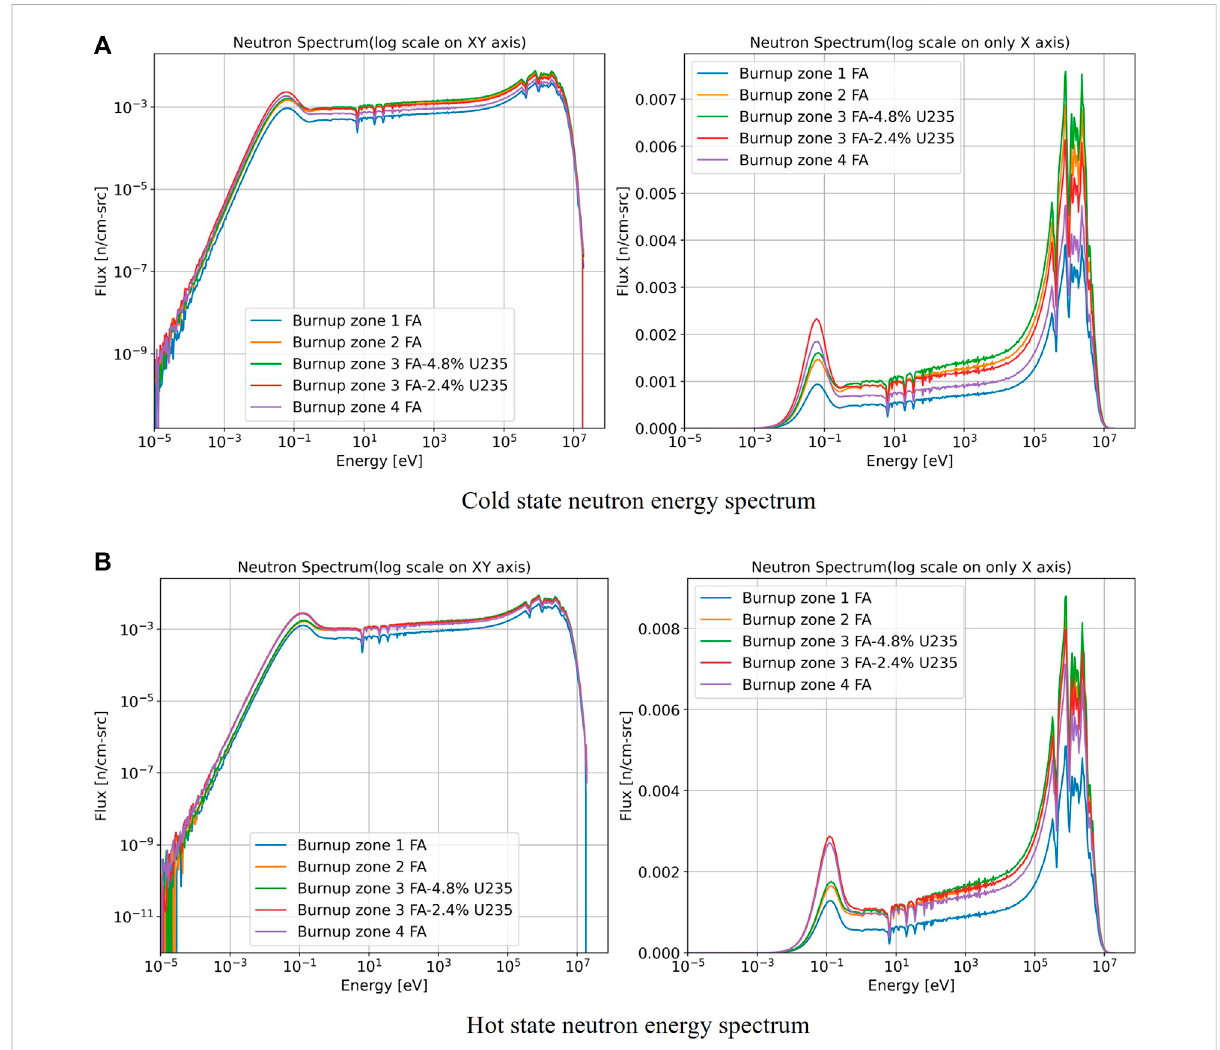
FIGURE 9 The neutron energy spectrums of different position fuel assemblies in the (A) cold and (B) hot